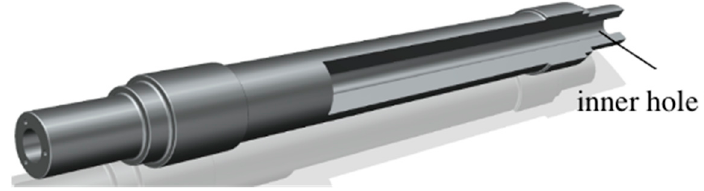
Figure 1. Hollow axle of high-speed-train.